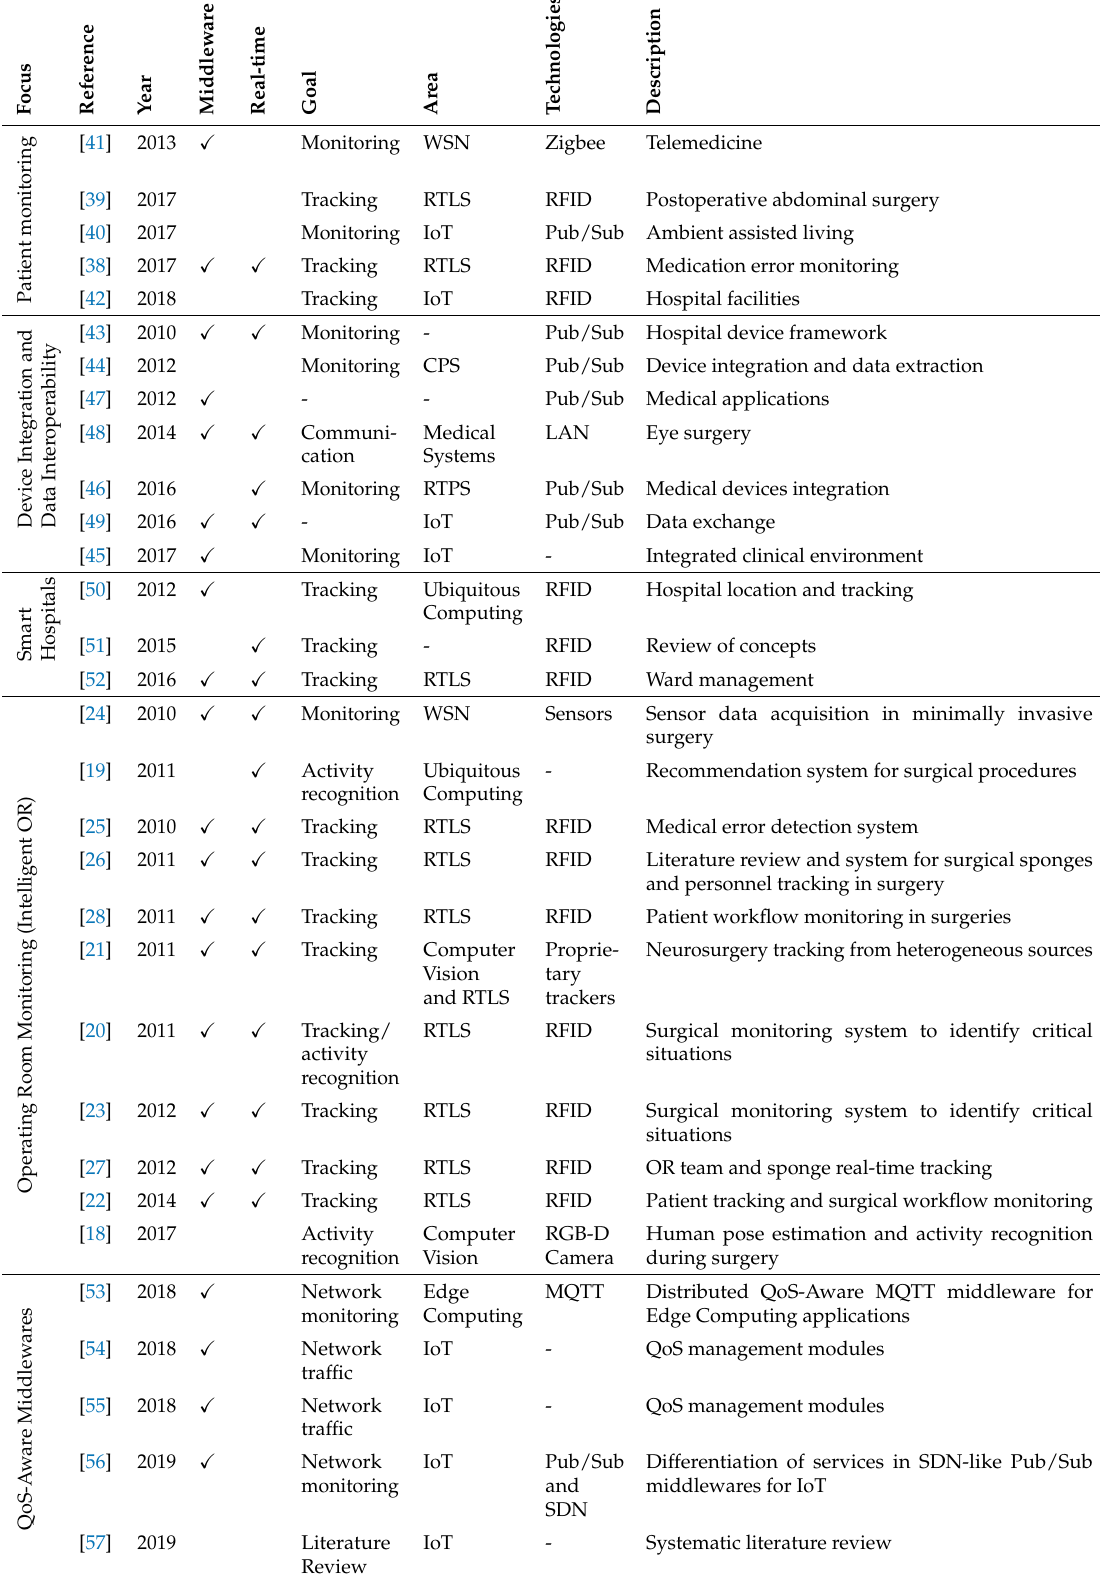
Table 1. Summary of articles resulting from the review